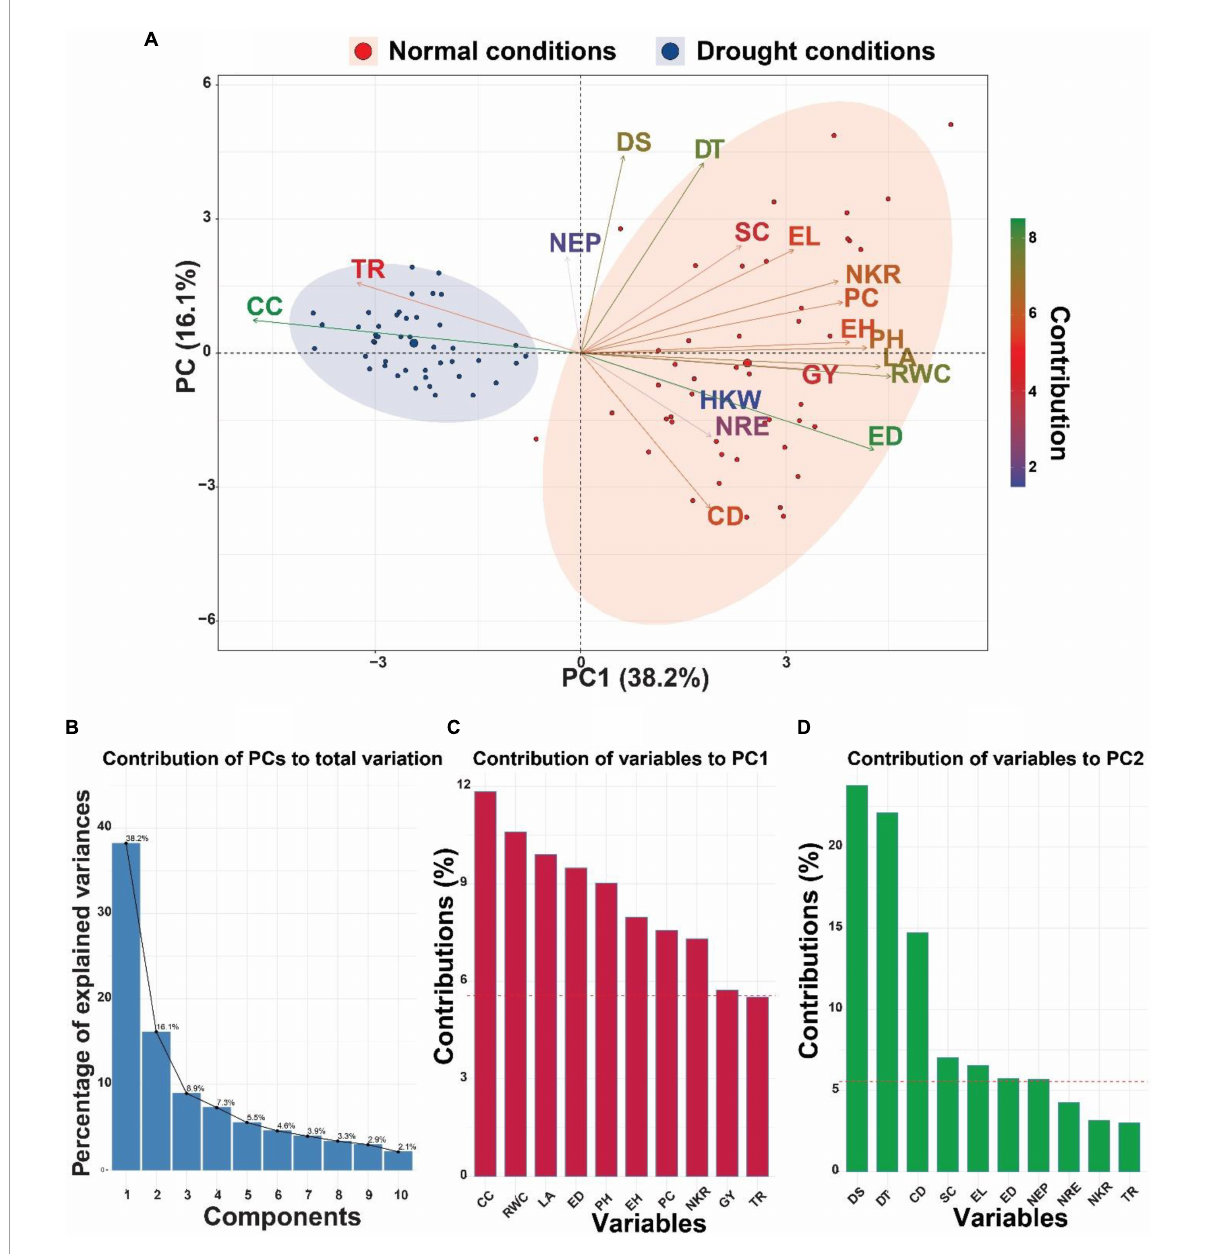
FIGURE2 (A) Principal component analysis (PCA)-biplot of 45 maize inbred lines based on the variance in 18 morpho-physiological and biochemical traits grown under normal and drought conditions. Arrows indicate the strength of the trait influence on the first two PCs. The darker green and longer arrows indicate a higher contribution, while the darker blue and shorter arrows indicate the lower contribution of the variables. (B) Bar plots with% variation above represent contribution of each PC to the total variation. (C,D) Red dashed lines in the bar plots denote reference lines and the variable bars above the reference lines are considered most important in contributing to the PC1 and PC2. DT, days to 50% tasseling; DS, days to 50% silking; PH, plant height (cm); EH, ear height (cm); NEP, no. of ears/plant; EL, ear length (cm); ED, ear diameter (cm); CD, cob diameter (cm); NRE, no. of row/ear; HKW, 100-kernel weight (g); NKR, number of kernel/row; GY, grain yield (ardbe/fed); LA, leaf area (cm 2 ); RWC, relative water content (%); PC, proline content (mg g - 1 ); CC, chlorophyll content (SPAD); TR, transpiration rate (mmol m - 2 s - 1 ); SC, stomatal conductance (mol m - 2 s - 1